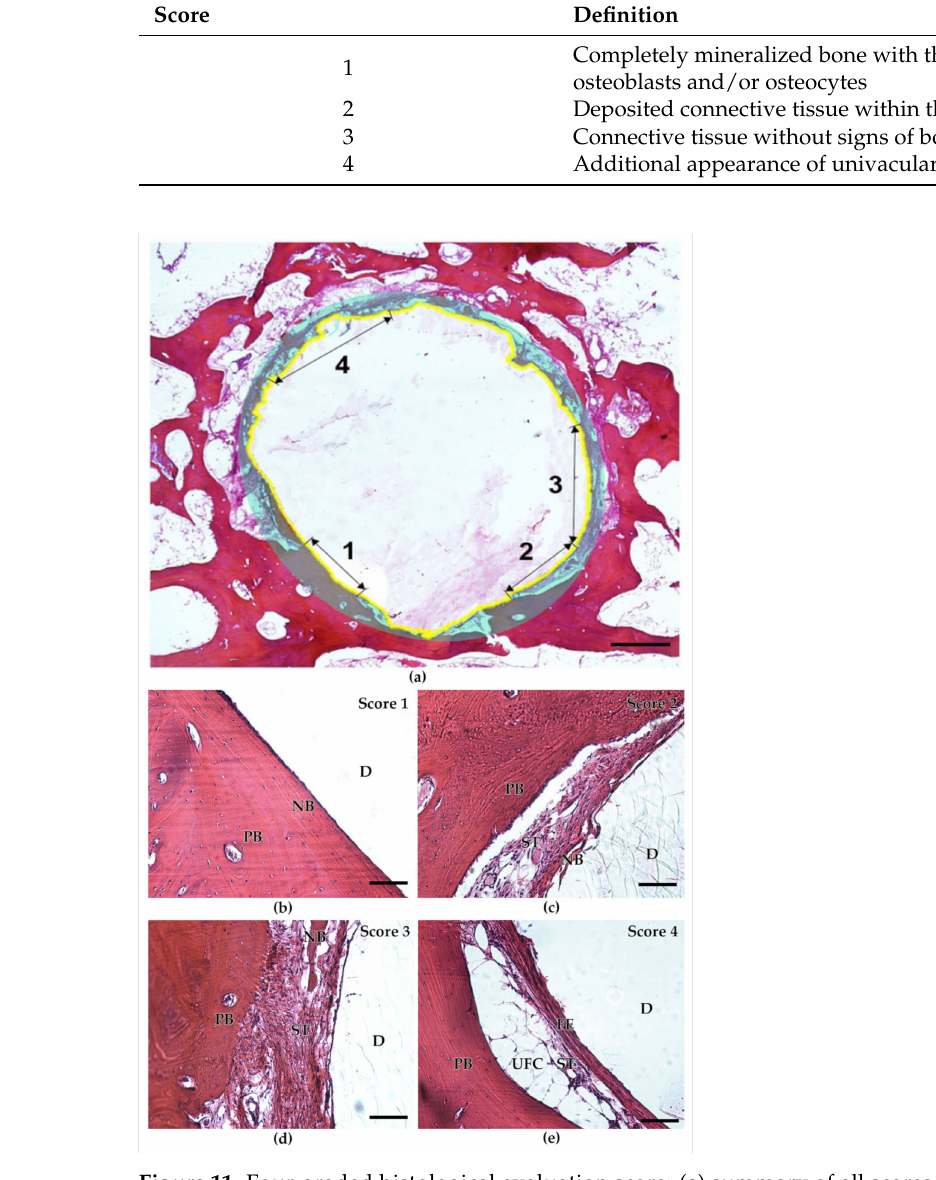
Figure 11. Four-graded histological evaluation score: ( a ) summary of all scores (1 to 4) blended in one single image. The ROI is marked by a greyish circular zone. Bone-to-biomaterial interface is indicated by a yellow line. Scale bar 500 µ m; ( b – e ) respective examples for each evaluation score. Scale bar 100 µ m. (D: defect zone with biomaterial remnants, NB: new-formed bone, ST: soft tissue, PB: peripheral bone, UFC: univacuolar fat cells, FE: fibrous